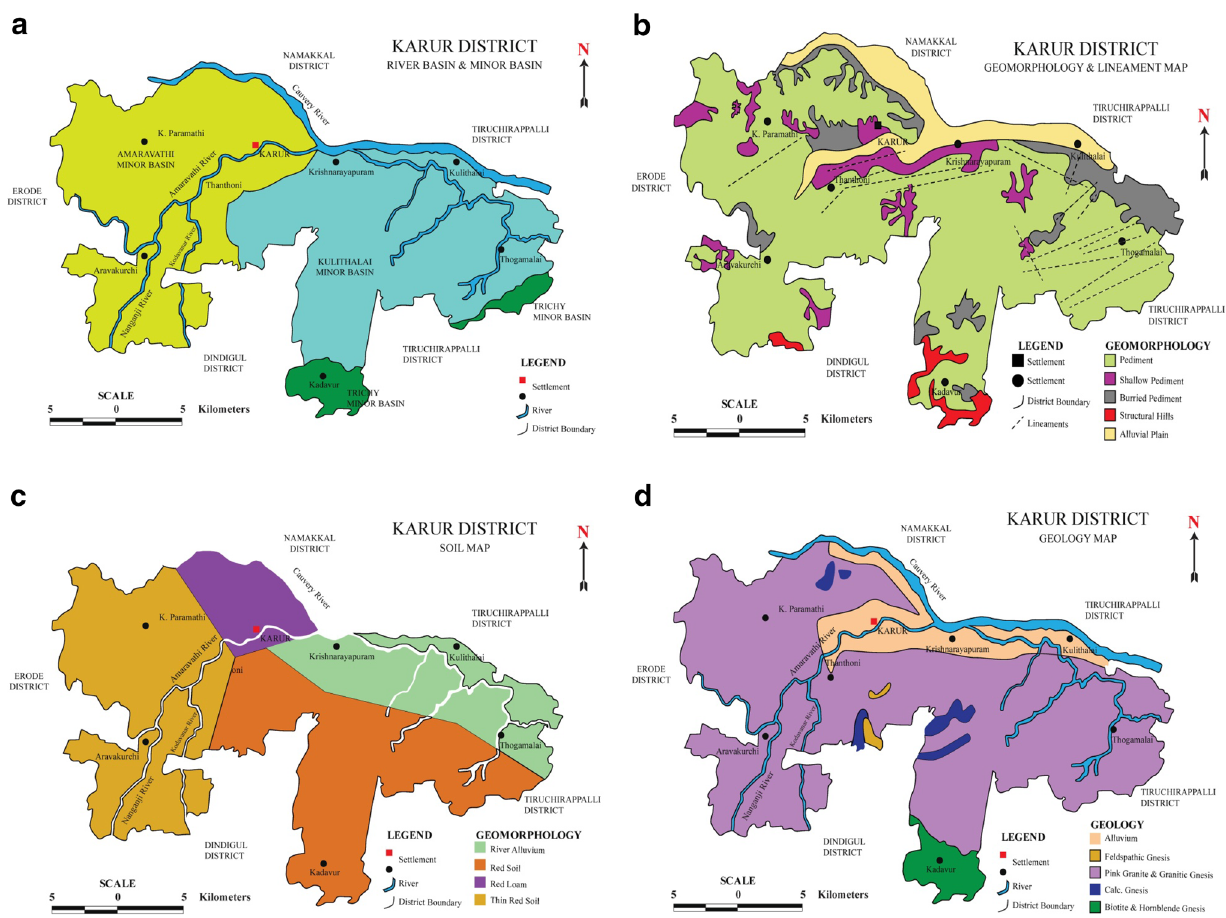
Fig. 2 a – d Map showing the river, geomorphology, soil, and geology of the Karur district Table 1 Ninefold land-use/land-cover statistics for the district S.